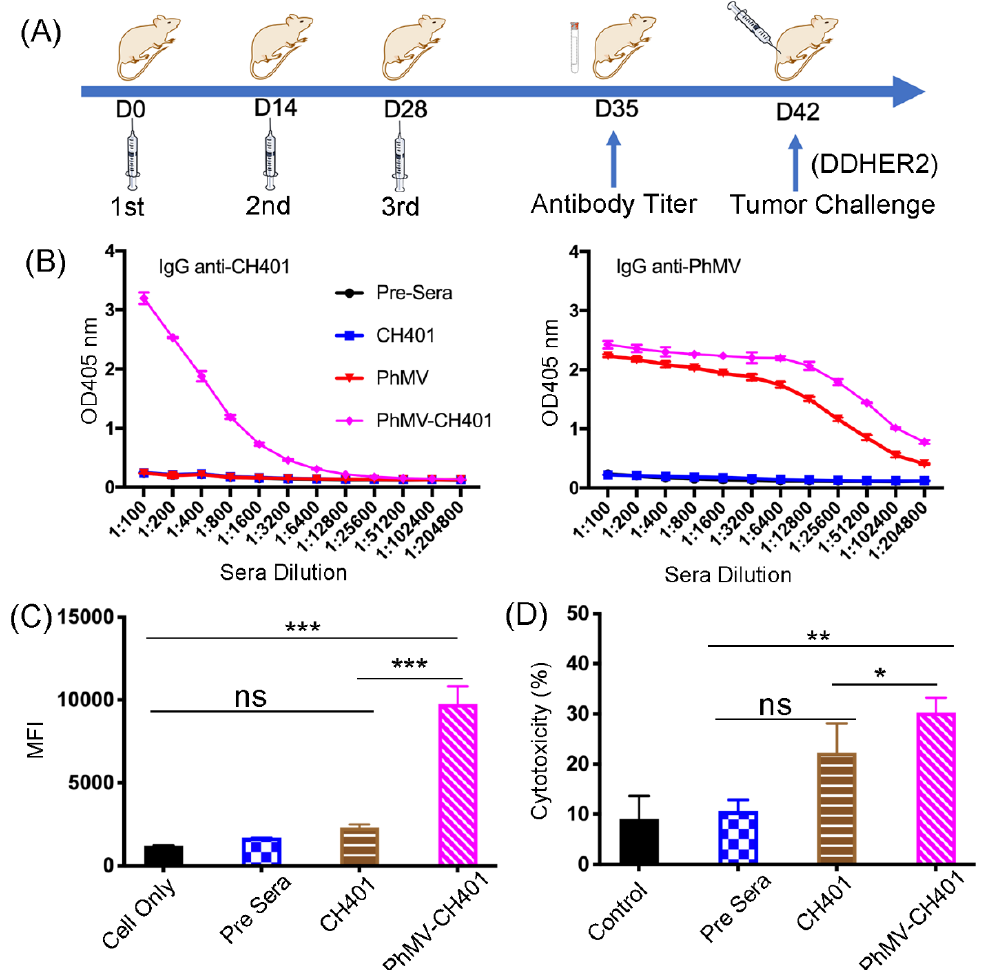
Figure 2. Immunological evaluation of the PhMV-based vaccines. ( A ) Immunization schedule using female BALB/c mice and subcutaneous administration of the vaccine candidates and controls; sera were collected before and after immunization, and the mice were challenged with DDHER2 cells through subcutaneous inoculation in the right flank on day 42 (2 weeks after the last immunization). ( B ) ELISA of the sera against CH401 peptide and native PhMV. ( C ) Flow cytometry analysis of the sera binding to DDHER2 cancer cells, the mean fluorescence intensity (MIF) of the triplicate experiments and standard deviations are shown. Data were analyzed using the FlowJo v10 software. ( D ) MTT assay of complement-dependent cytotoxicity induced by the sera against DDHER2 cells. Cytotoxicity (%) = 100 (experimental OD/control OD) × 100. Mean cytotoxicity of triplicate experiments and standard deviations are shown. Statistical analysis by one-way ANOVA with Tukey’s test: ns = not significant; * p < 0.05; ** p < 0.01; *** p < 0.001.